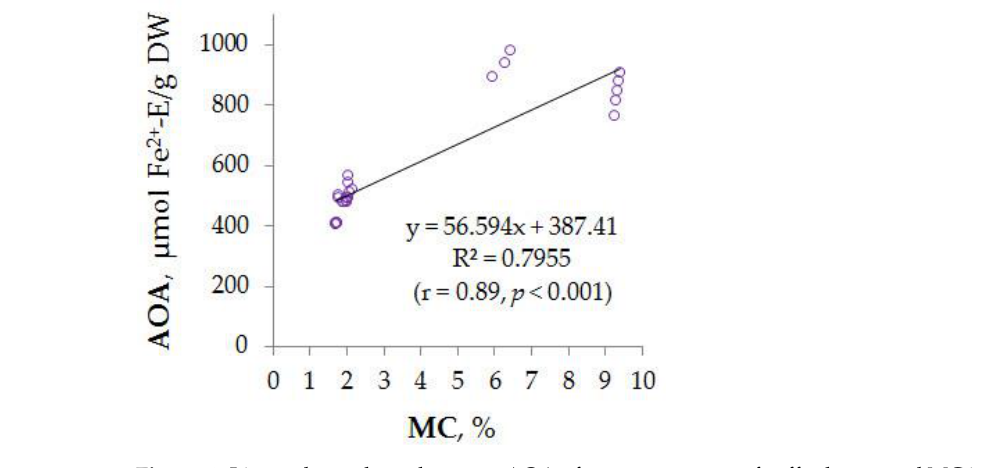
Figure 4. Linear dependence between AOA of aqueous extract of coffee beans and MC in coffee beans.